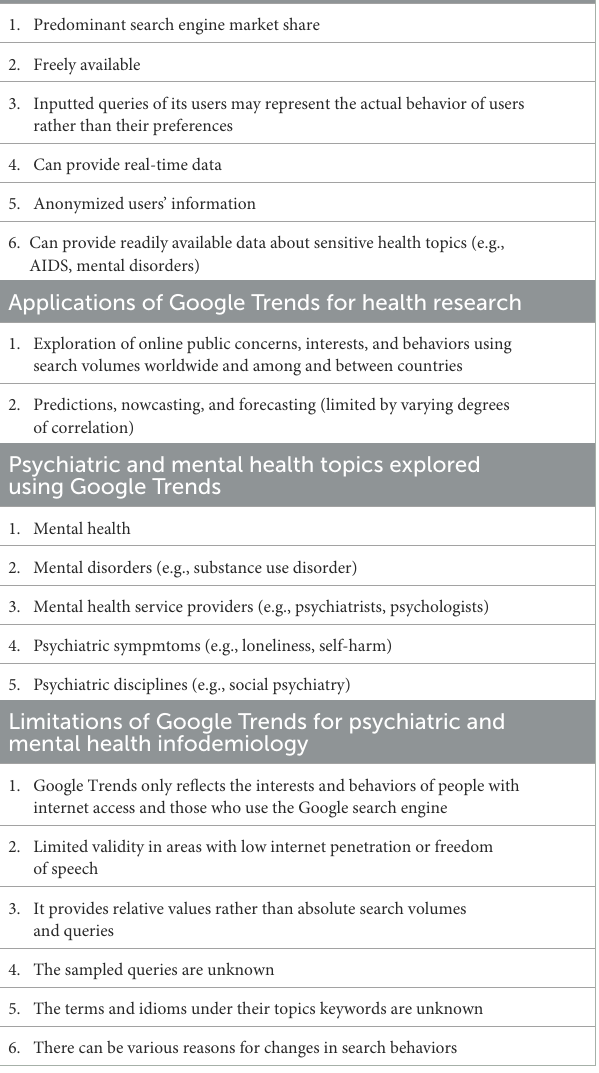
TABLE 2 Suggested minimum methodological documentation and consideration by studies using Google Trends for psychiatric and mental health